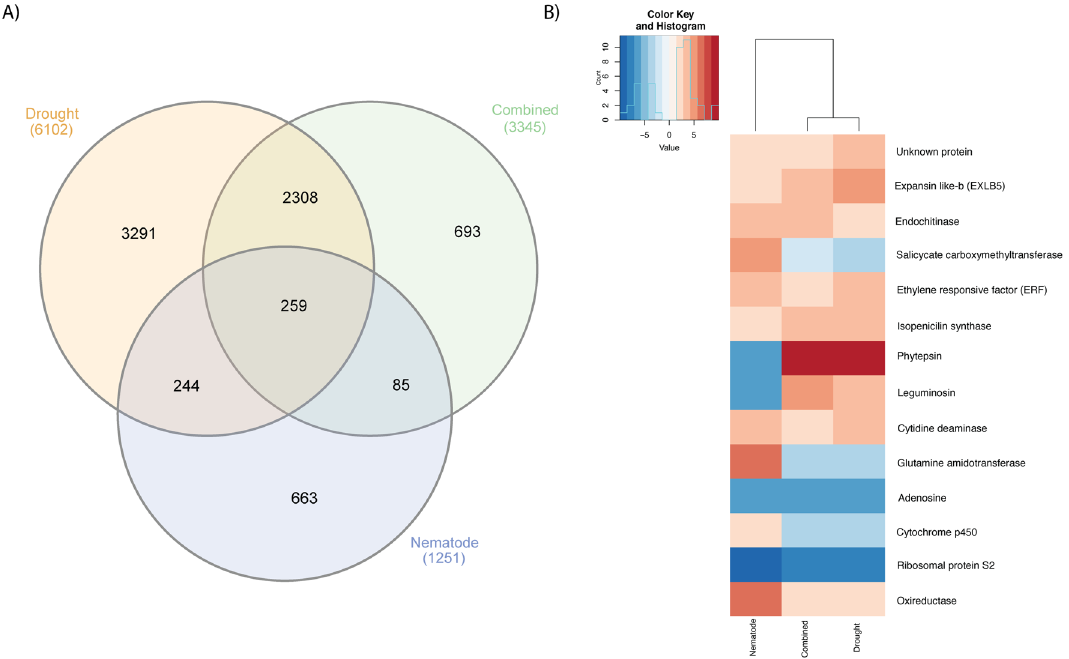
Figure 5. A. stenosperma DEGs from de facto transcriptome in response to biotic (nematode) and abiotic (drought) treatments and their combination (crossDEGs). (A) Venn diagram of de facto DEGs from the nematode, drought and combined treatments. (B) Expression values of 14 de facto DEGs with the highest expression values to all treatments heatmap generated by